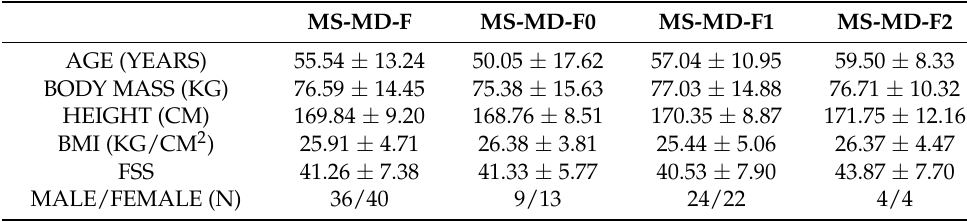
Table 1. Baseline